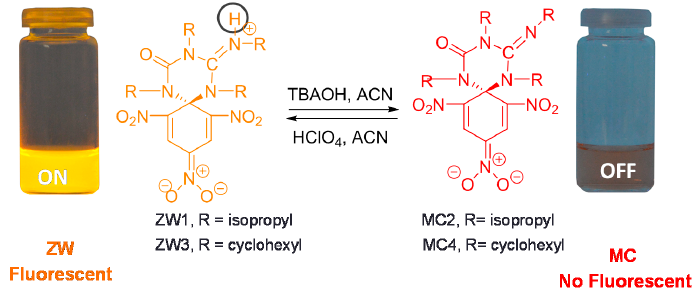
Scheme 2. Fluorescence switching (on = ZW/off = MC) of ZW upon addition of base and